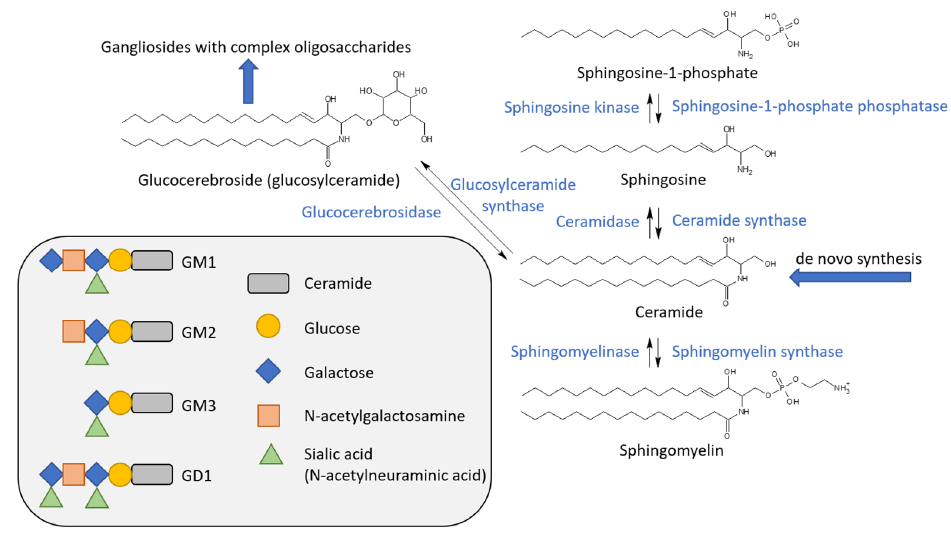
Figure 4. Brief biochemistry of sphingolipids. Ceramide is at the center of the biochemical pathways of sphingolipids. Enzymes are written in blue in the figure. De novo synthesis of ceramide from palmitate and serine takes place in the endoplasmic reticulum. It can be converted to sphingomyelin by the transfer of phosphocholine from phosphatidylcholine by sphingomyelin synthase located in the Golgi complex or at the plasma membrane. By cleaving the fatty acid from ceramide, ceramidase produces sphingosine that can be further phosphorylated to sphingosine-1-phosphate. Addition of glucose to ceramide results in glucocerebroside from which gangliosides with complex oligosaccha- rides can be synthesized. The nomenclature of gangliosides is briefly summarized in the insert on the left. 4. Lipid Alterations in Cancer and Possible Applications of Lipid Therapy Considering the substantial role of various lipids in the functional modulation of membrane proteins, including RTKs, and the importance of these receptors in neoplasms, the connection between lipids and tumors seems obvious. Consistently, cancerous trans- formations are generally coupled with changes in membrane lipid composition and struc- ture. While the recognition of these alterations is crucial for understanding the connection between tumors, lipids, and RTKs, its detailed analysis is beyond the scope of the current manuscript and, therefore, we limit the discussion to describing the basics in this section and refer to excellent recent reviews in the field. While oncological research focused mainly on genetic changes and alterations related to proteins in the past, recent advances in lipidomics and membrane biophysics have stim- ulated studies investigating lipid-related changes and their effects on proteins such as RTKs in tumors [216,217]. Although various normal tissues, and therefore neoplasms orig- inating from them, are characterized by a unique and dynamic set of lipids, altered lipid metabolism and consequent abnormal lipid composition are near-universal hallmarks of human tumors due to increased lipid uptake and reactivation of de novo fatty acid and cholesterol biosynthesis. Aberrant activation of enzymes such as fatty acid synthase, ace- tyl-CoA carboxylase, ATP-citrate lyase, and transcription factors such as sterol regulatory